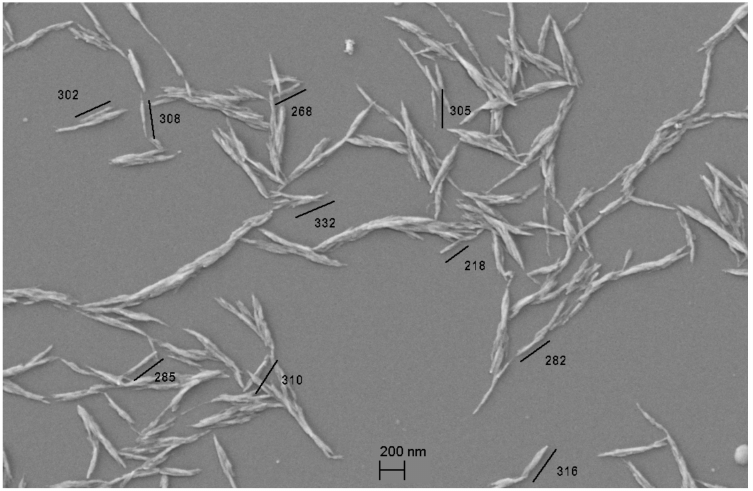
Figure 1. SEM micrography of the cellulose nanocrystals isolated by a ‘polyol method’.